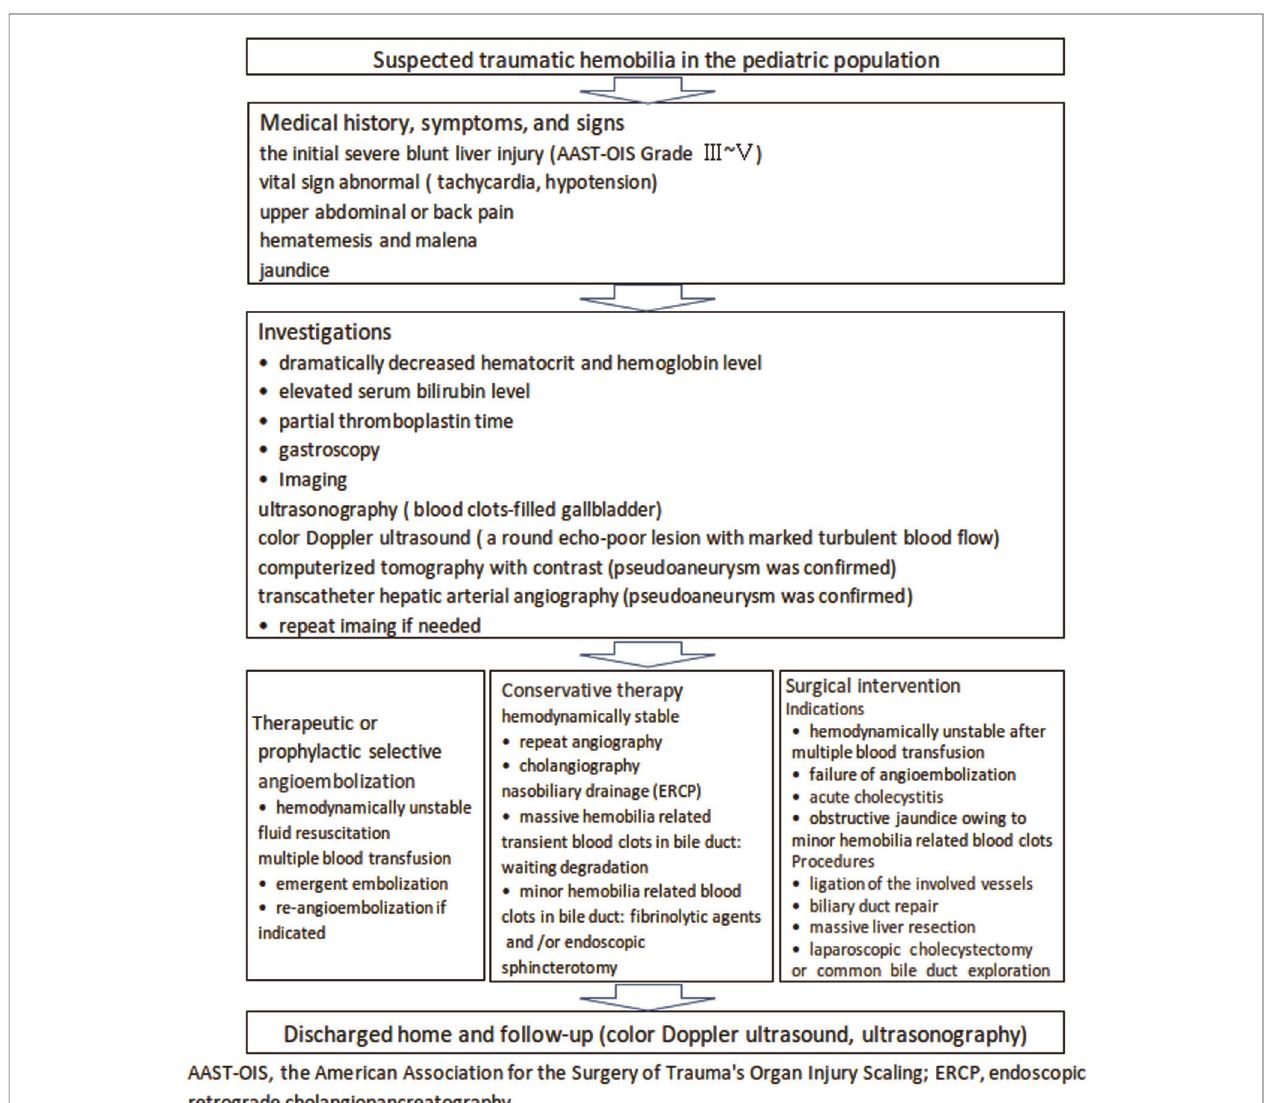
FIGURE 3 | A recommended fl owchart for the diagnosis and management of traumatic hemobilia in the pediatric population based on the literature and our preliminary